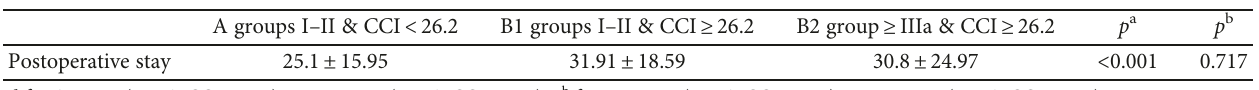
Table 2: Di ff erence in postoperative stay using di ff erent measurements in patients with postoperative complications after curative resection of gastric